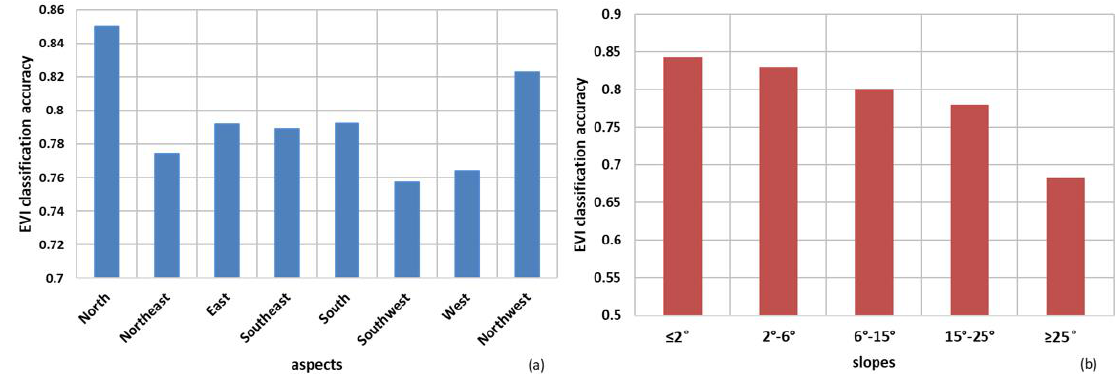
Figure 7. Classification accuracies summarized for various ( a ) slopes and ( b ) aspects.